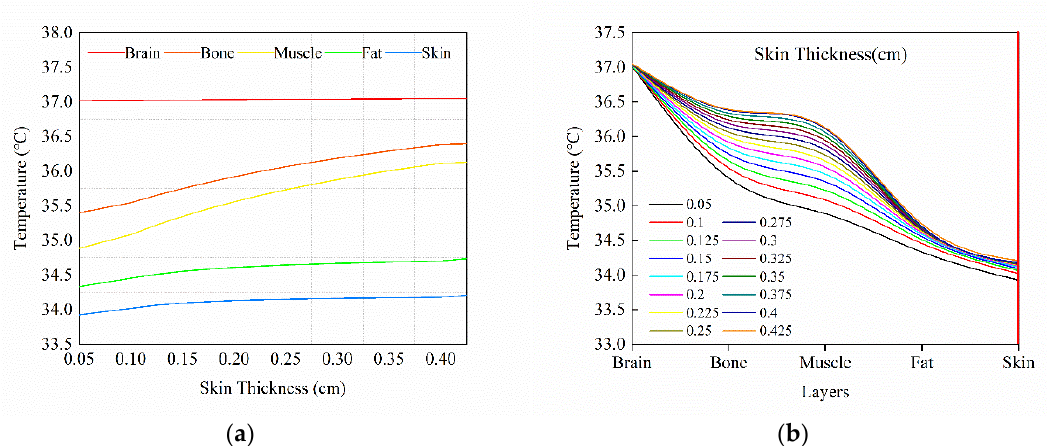
Figure 9. ( a ) Temperature variation by skin thickness step change; ( b ) Tissues temperature distribution under different skin thickness.